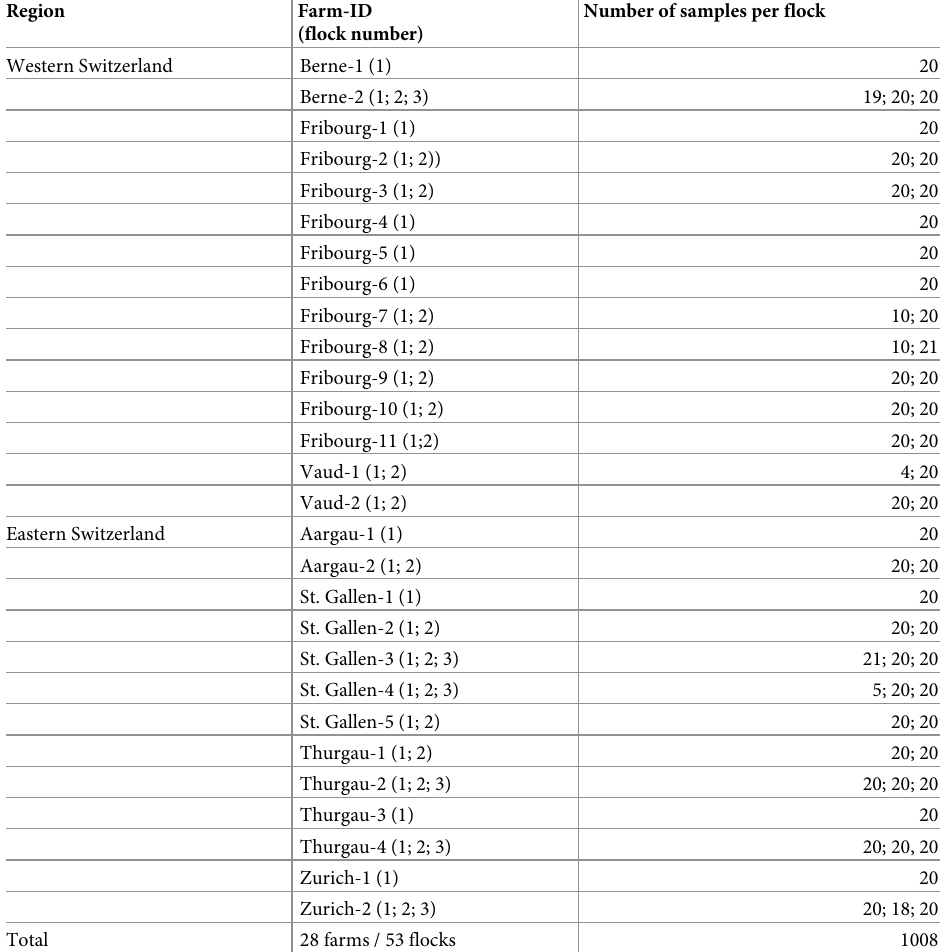
Table 1. Number of cloacal swab samples from Swiss turkey farms located in seven different cantons. Farm-ID consists of the canton where the farm is located followed by a consecutive number. Region Farm-ID Number of samples per flock (flock number) Western Switzerland Berne-1